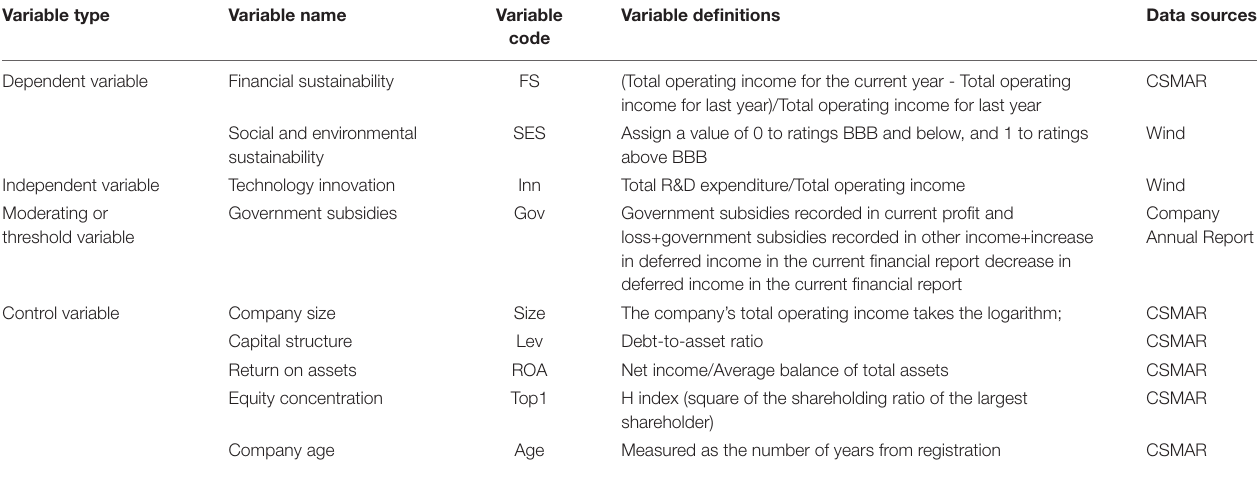
TABLE 2 | Independent variable, dependent variable, moderating (threshold) variable, and control variable